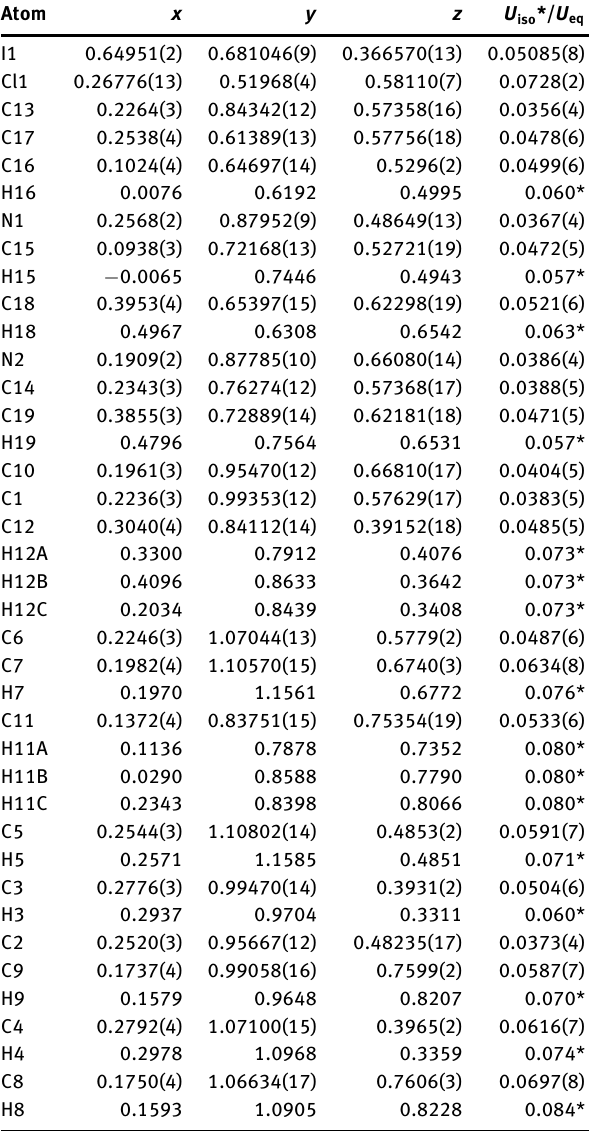
Table 2: Fractional atomic coordinates and isotropic or equivalent isotropic displacement parameters (Å 2